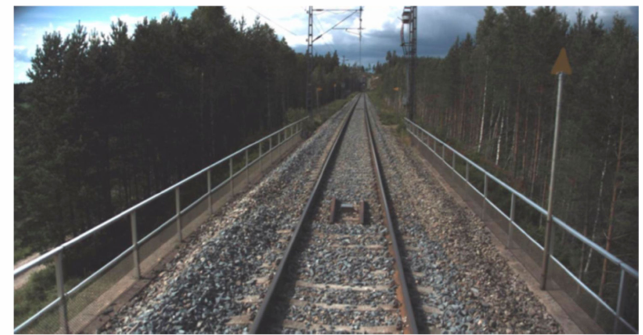
Figure 8. Section of rail in Transition Zone